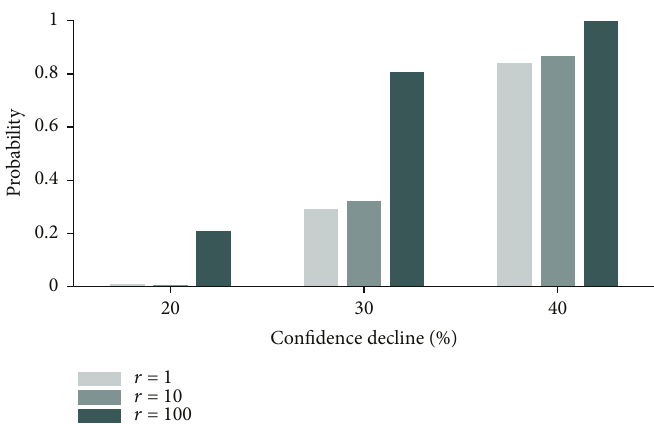
Figure 10: Probability of systemic breakdown for various magnitudes and speeds of con fi dence ( C ) decline. The magnitude of decline refers to the percentage of the initial value of C that is lost. The speed of decline is determined by the parameter r of the exponential function f x = e − rx ; the greater the value of r , the greater the speed of C decline. The sudden decline of C ( r = 100 ) is associated with a sharp increase in the probability of systemic breakdown, especially in the cases of 20% and 30% of C decline.